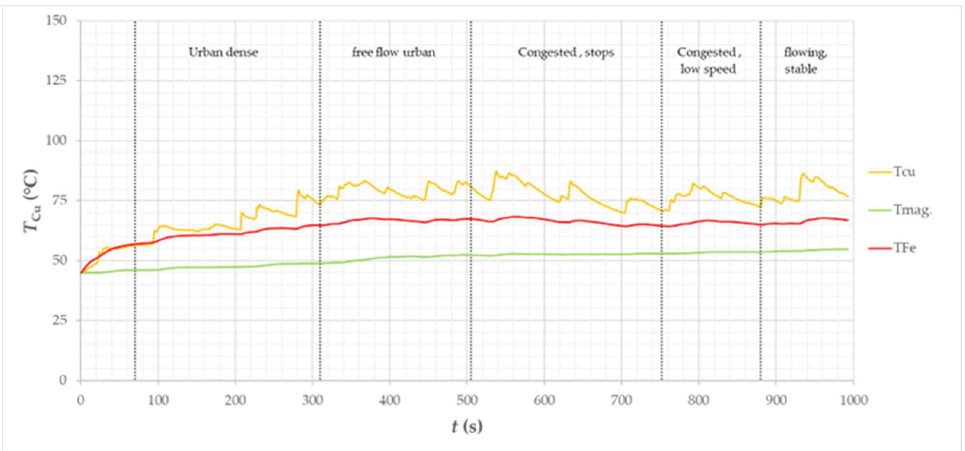
Figure 20. Calculated temperature curves in the winding (hot spot), in permanent magnets, and in the stator yoke of the motor for the considered vehicle in the Artemis Urban driving cycle